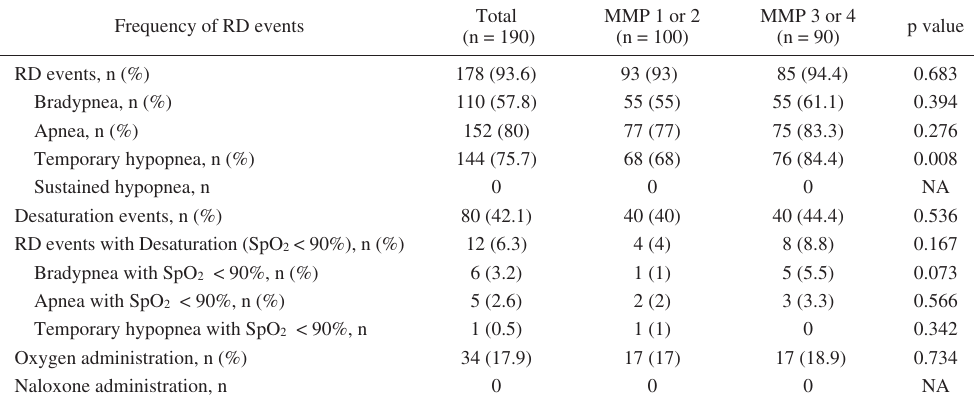
Table 2. Frequency of RD events.